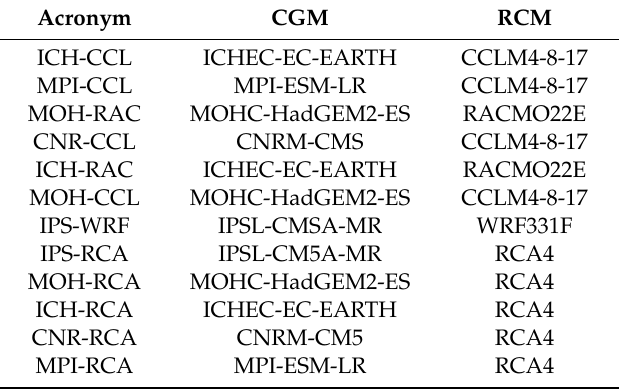
Table 2. EURO-CORDEX climate models used in the